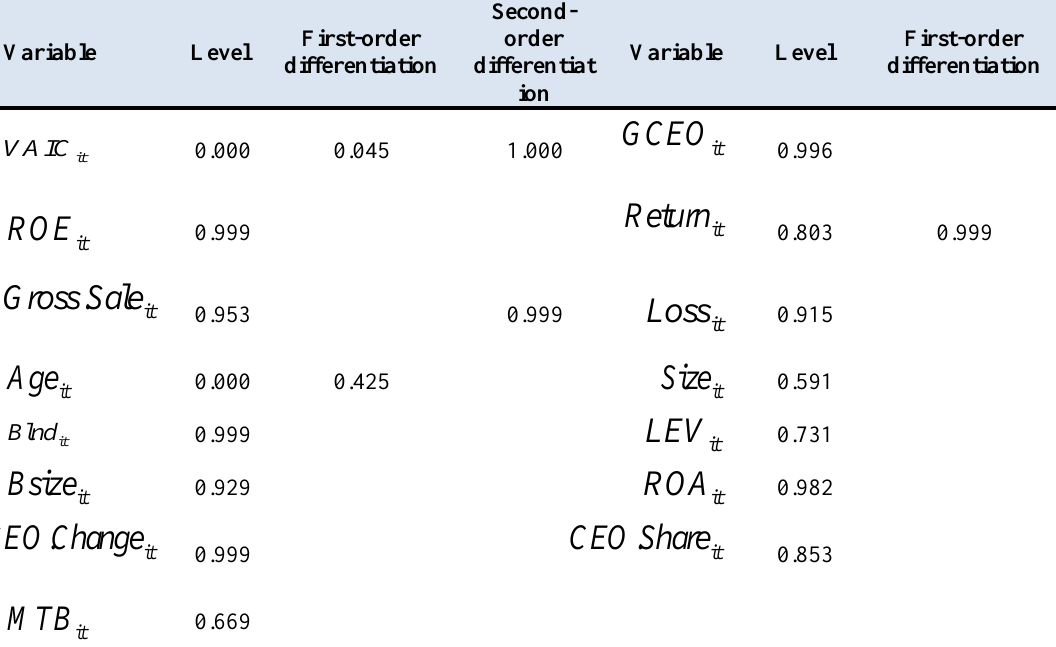
First-order differentiation